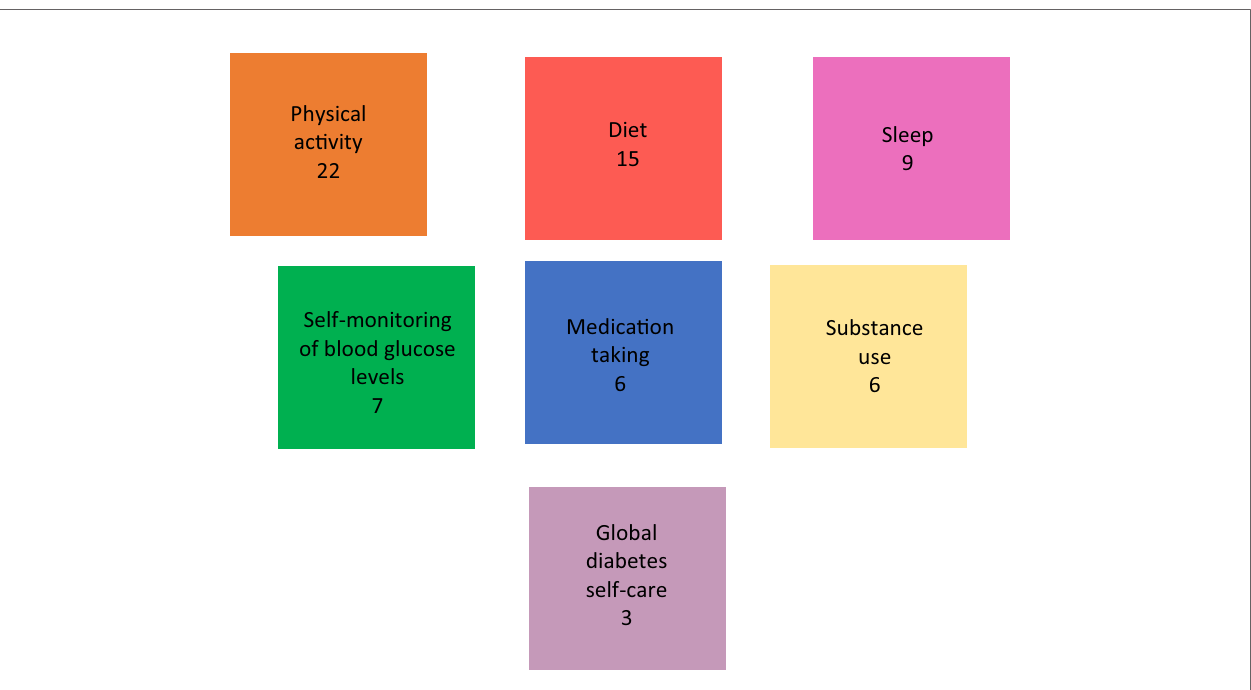
FIGURE 2 | Map of health behaviors measured by number of